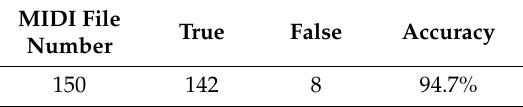
Table 3. Accuracy of extracted melody